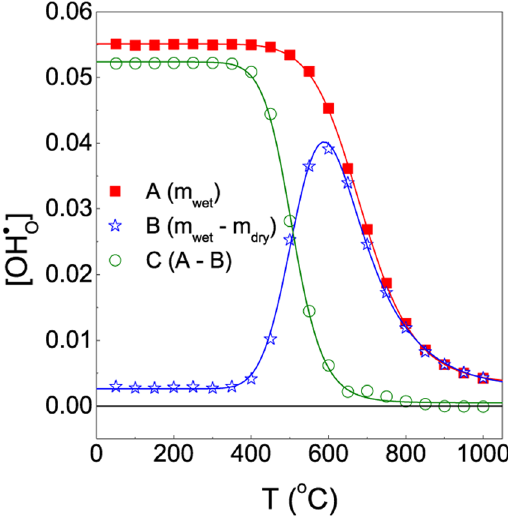
Figure 3. Generated proton concentration under wet condition (A-line), proton concentration caused by condition between dry and wet (B-line), and difference of proton concentration between A- and B- line (C-line).